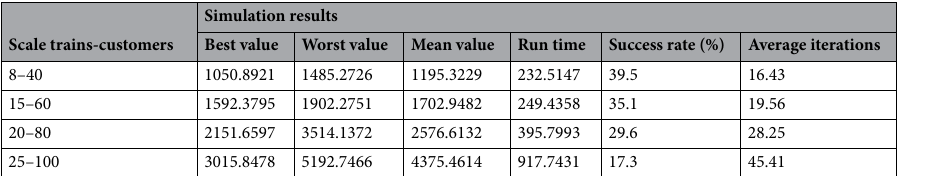
Table 4. Comparison and analysis of running results of different